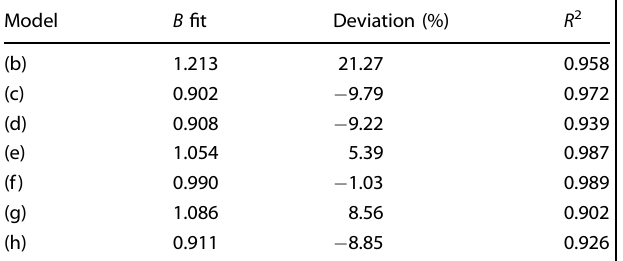
Table 1. Summary of β fi t coef fi cients and deviation from fl icker noise. Models (a) – (h) coincide with the order presented in Fig.